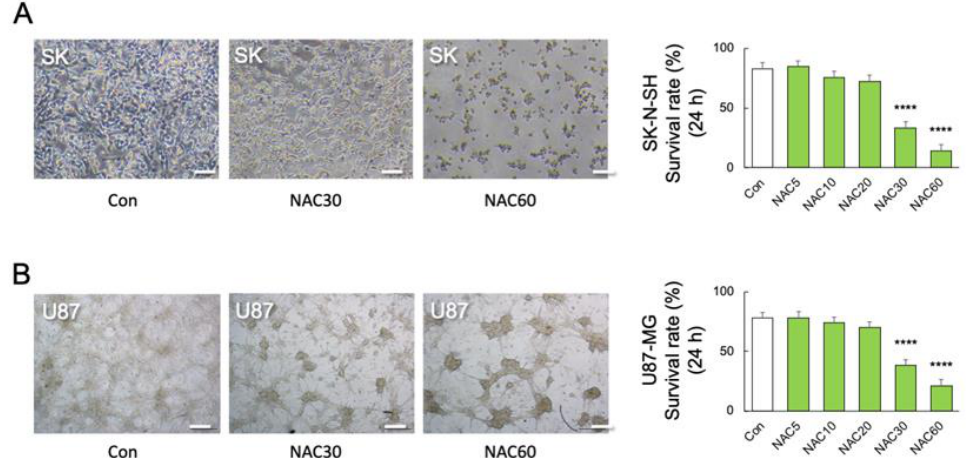
Figure 5. Effects of NAC on LPS-induced mortality in neuronal and astrocytic cells. ( A ) Representa- tive images and quantitative analyses of SK-N-SH (SK) cell viability after 24 h of treatment with different doses of NAC treatments (0, 5, 10, 30, and 60 mM) (n = 6). **** p < 0.0001, vs. NAC 0 mM (Con). ( B ) Representative images and quantitative analyses of U-87 MG (U87) cell viability after 24 h of treatment with different doses of NAC (0, 5, 10, 30, and 60 mM) (n = 6). **** p < 0.0001, vs. Con. Scale bars, 250 μm. All data are presented as MEAN ± SEM.